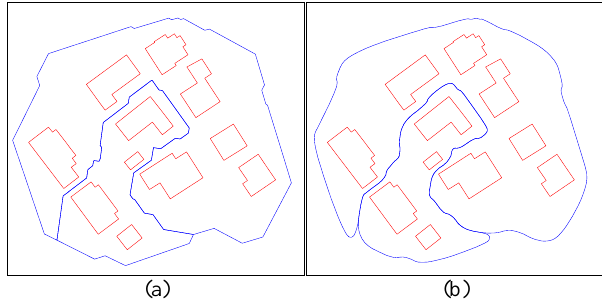
Figure 2. Aggregated privacy regions before (a) and after borderline smoothing